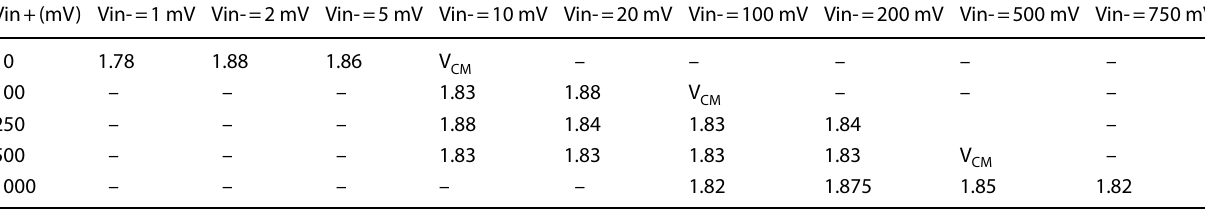
Table 4 Differential voltage gains for peak output voltages in Table